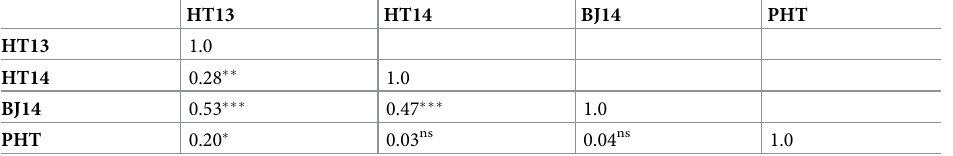
Table 6. Pearson correlation coefficients for disease severity (%) and plant height to Septoriatritici blotch in Holeta (2013 and 2014) and Bekoji (2014),